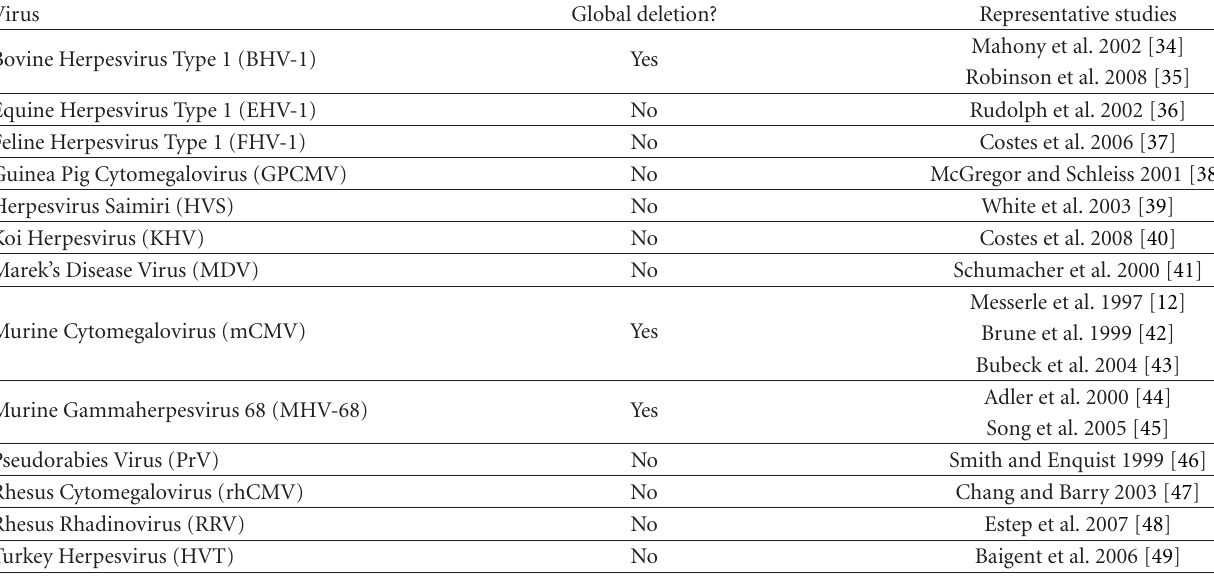
Table 2: Selected BAC-based animal herpesvirus